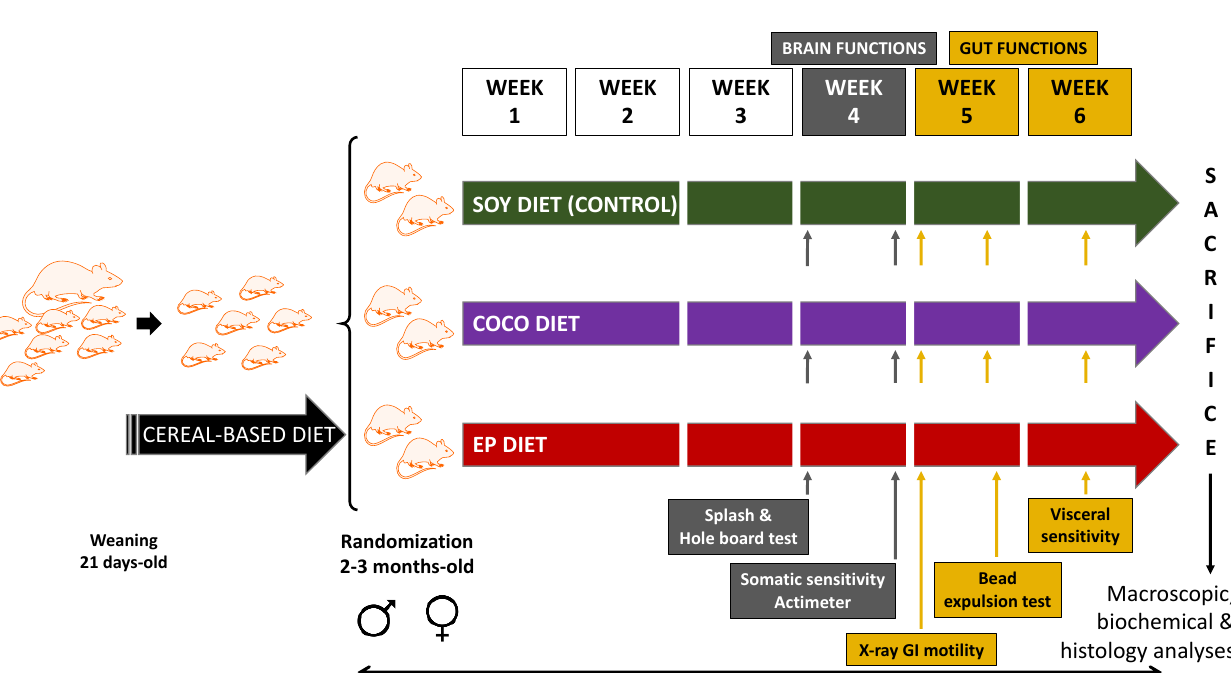
Figure 1. Study protocol. Rats were fed on a standard, cereal-based diet until the age of 2–3 months. Then, they were randomly allocated to three diet groups: SOY diet, i.e., the validated AIN-93G diet, whose only source of fat is soybean oil; COCO diet, i.e., AIN-93G diet enriched in coconut oil (rich in saturated fatty acids); and EP diet, i.e., diet enriched in evening primrose oil (rich in polyunsaturated fatty acids). SOY diet was the control diet of the study. Body weight, food and water intakes were recorded during the study. Brain functions were evaluated during week 4 of diet intervention using splash and hole-board tests, somatic sensitivity tests, and actimeter. Gut functions were estimated from week 5 to week 6 on the basis of X-ray motility analysis, colonic bead expulsion test, and visceral (colonic) sensitivity. After six weeks of diet intervention animals were sacrificed, and macroscopic, biochemical, and histology analyses were performed. Animals used for visceral sensitivity studies were not used for plasma/tissue collection.